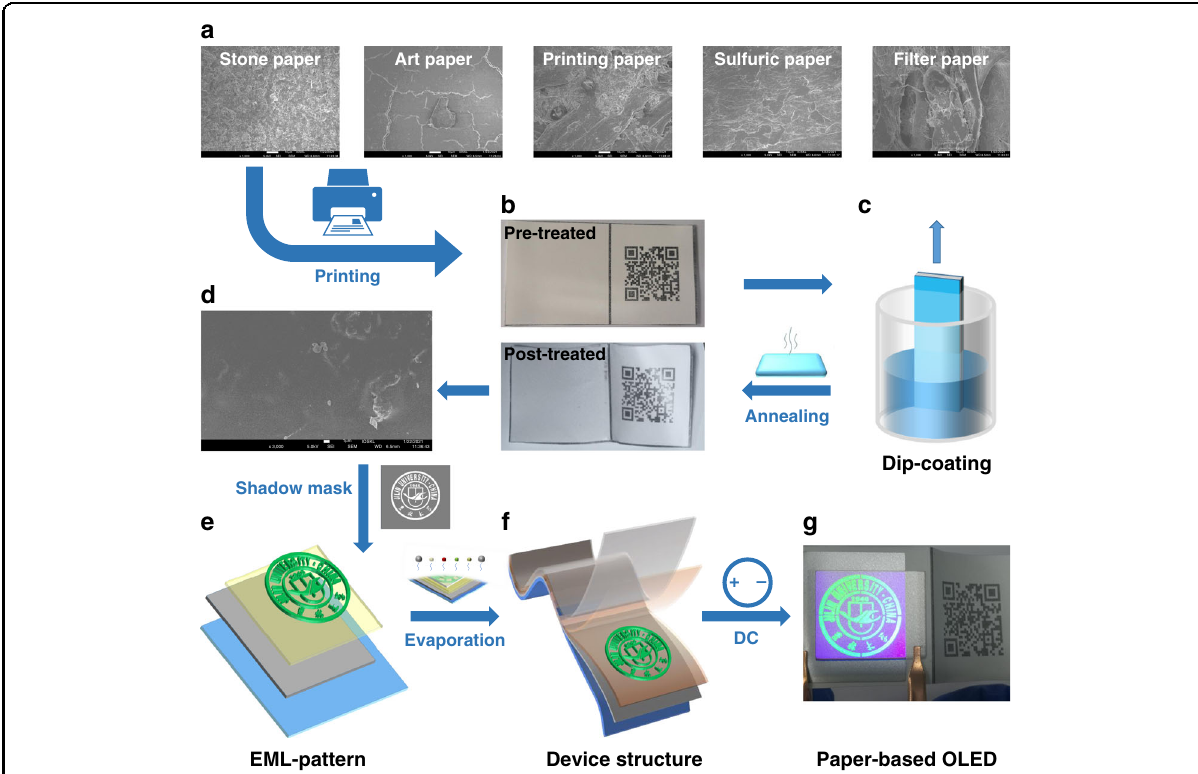
Fig. 1 Organic light-emitting paper preparation. a SEM images of various types of commercially available paper. b Images of stone-paper substrates with QR code before and after dip-coating process. c Schematic diagram of the dip-coating process. d SEM image of stone paper treated by the dip-coating process. e Schematic diagram of patterned emitting layers. f Schematic diagram of the device structure of OLEDs. g Image of organic light-emitting paper at 5